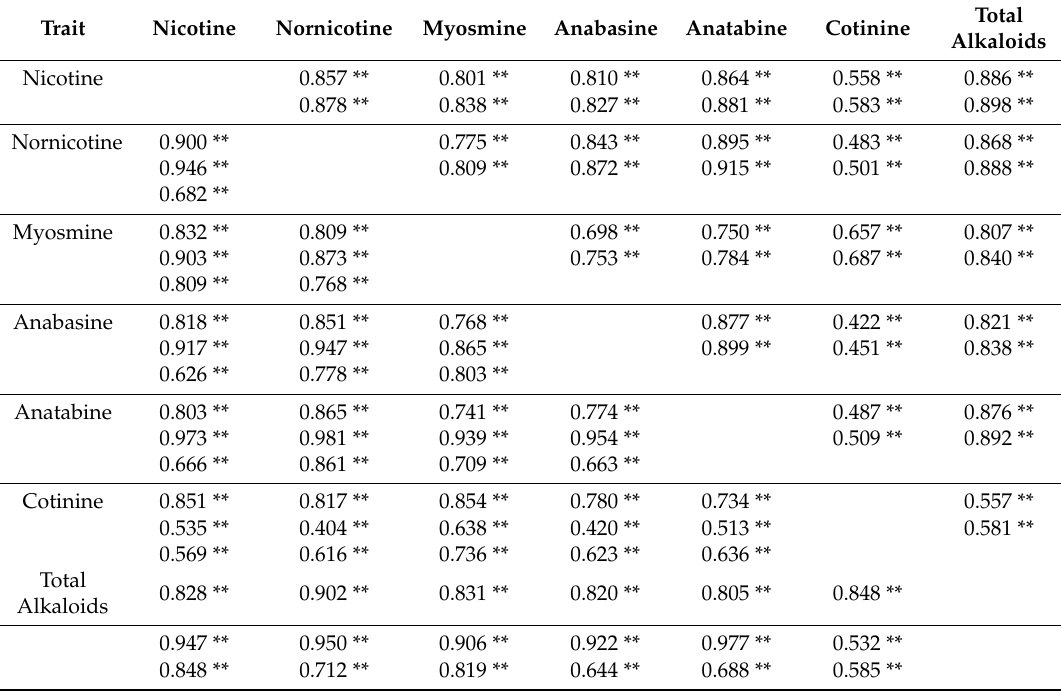
Table 6. Correlation coefficient between pairs of alkaloids in Nicotiana tabacum leaves.